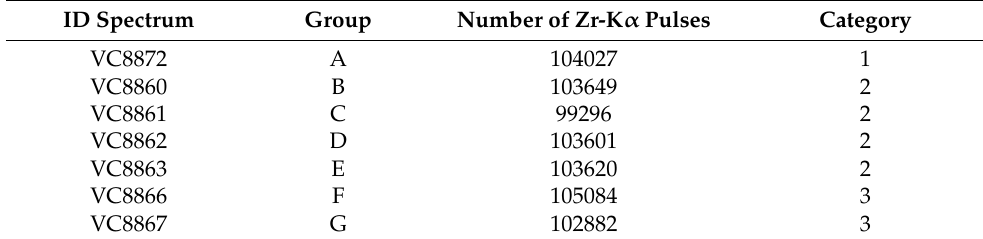
Table 6. Results of energy dispersive X ‐ ray fluorescence analysis.